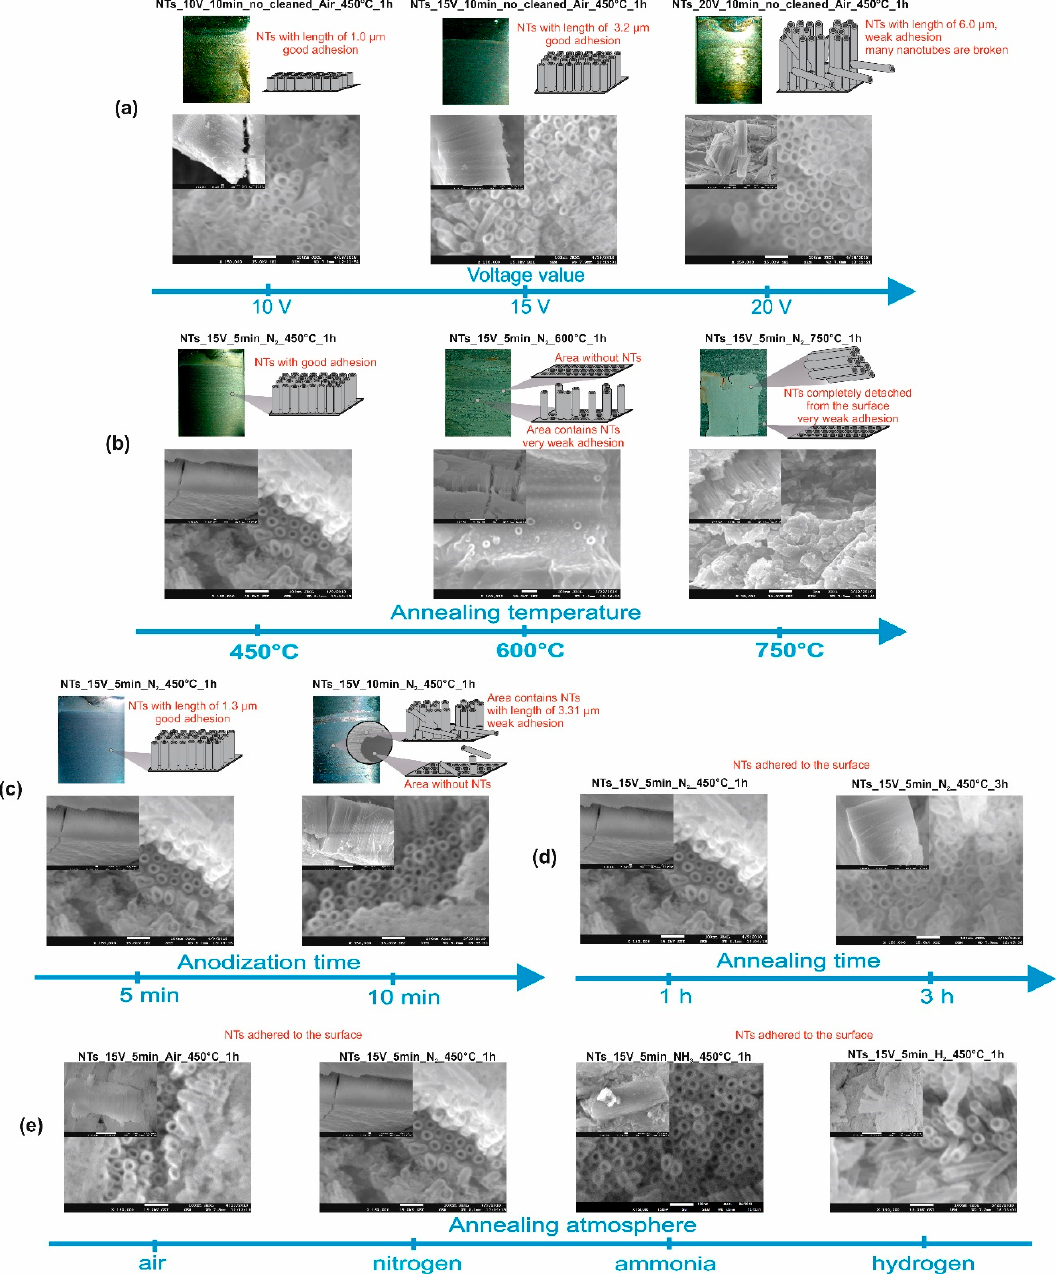
Figure 1. Scanning electron microscope (SEM) images of nanotube arrays (NTs): the effect of ( a ) applied voltage, ( b ) annealing temperature, ( c ) anodization time, and ( d ) annealing duration, ( e ) annealing atmosphere on the morphology and adhesive properties of tantalum pentaoxide (Ta 2 O 5 ) nanotubes.